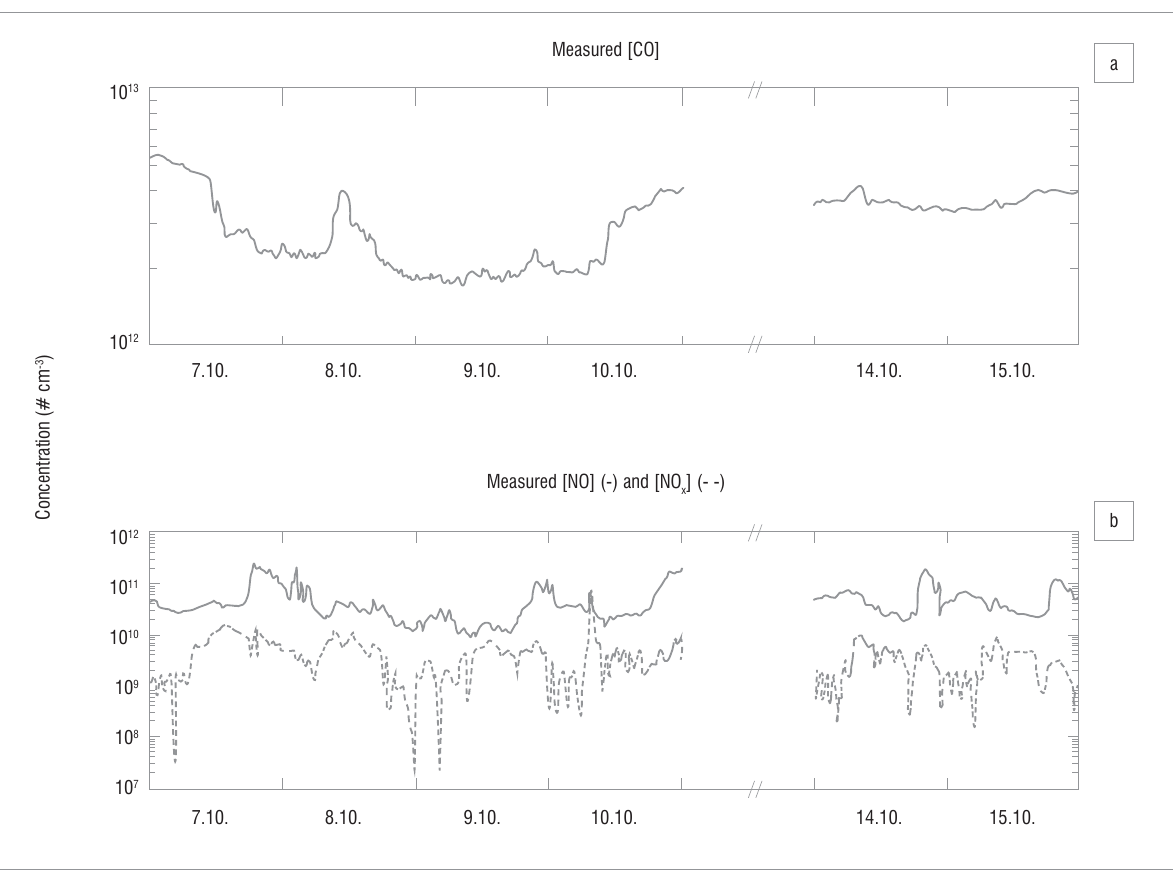
(--) concentrations in October 2007 (gap filling applied when x